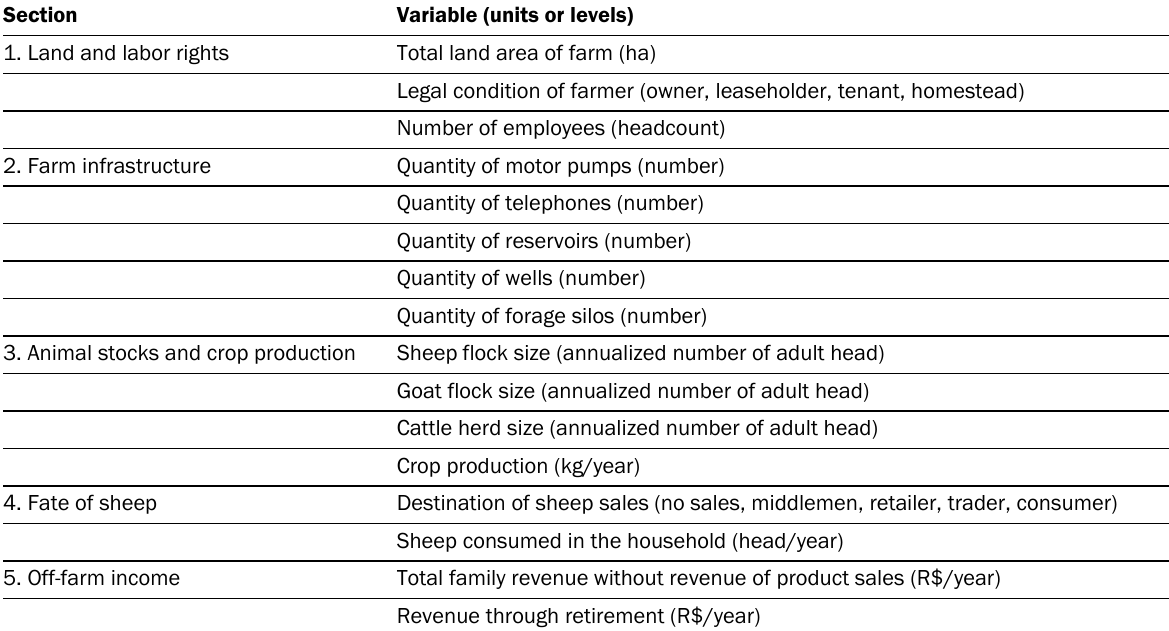
Table 1. Variables Used in the Multiple Correspondence Analysis